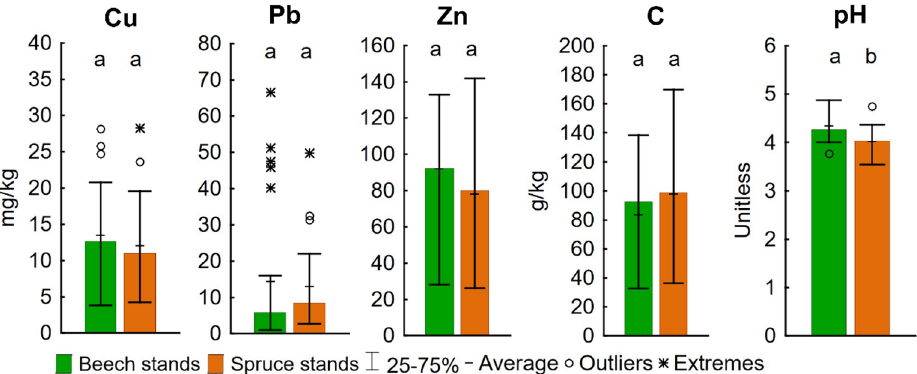
Figure 2. Medians of PTEs contents, pH and C contents in beech and spruce stands soils; different lowercase letters indicate significant differences between forest types (Mann–Whitney U test, p = 0.05).